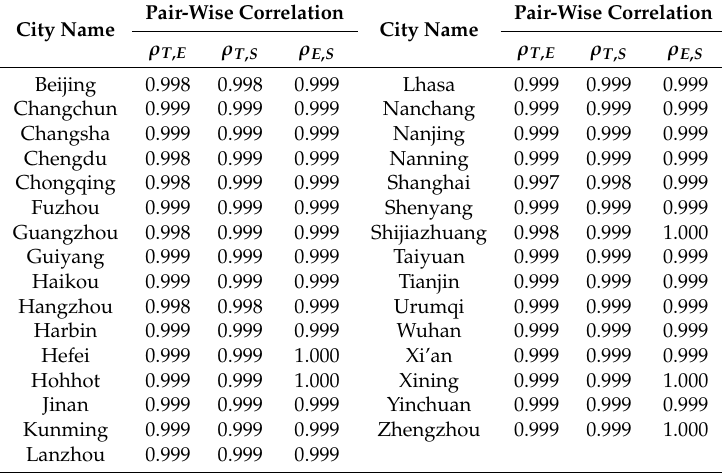
Table A2. Correlations among taste ( T ), environment ( E ) and service ( S ) of restaurants that serve regional Chinese cuisines (i.e., type 1–19) in the 31 cities.